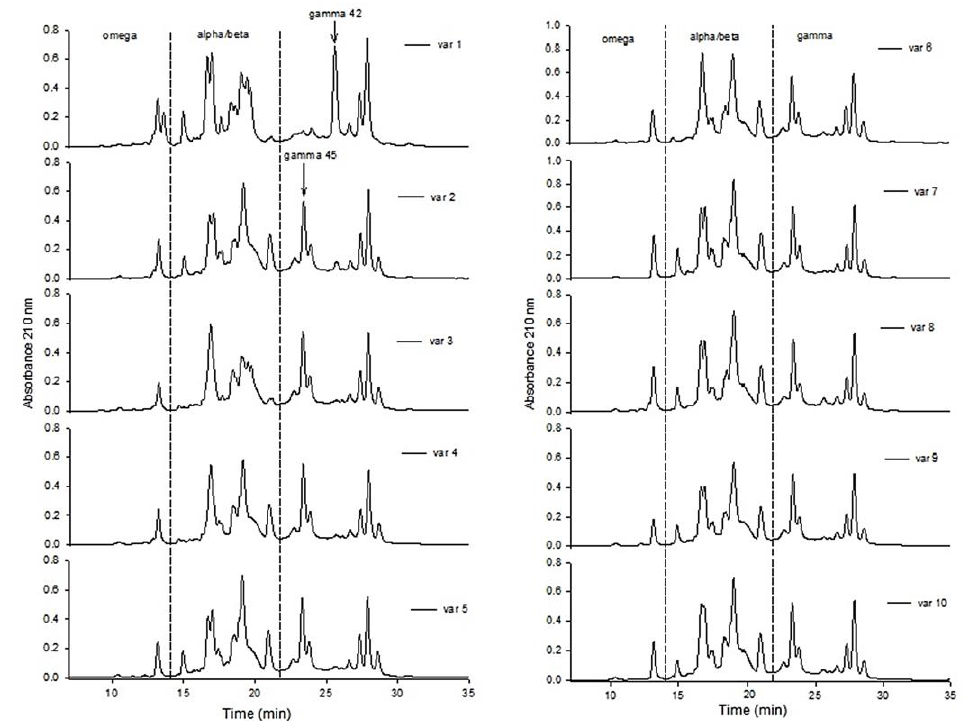
Figure 3. RP-HPLC profiles of gliadins (ethanol extracts) for the studied wheat varieties.